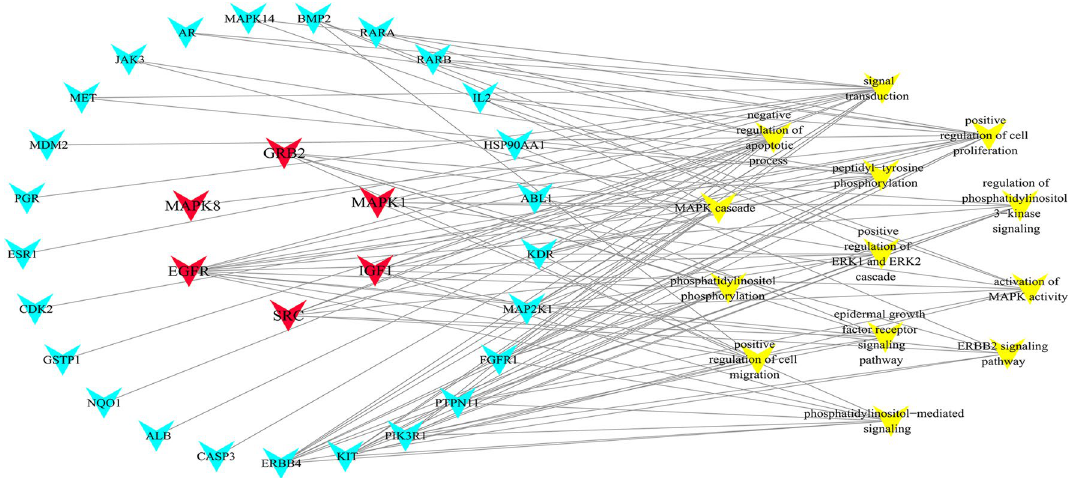
Figure 6. The network made in Cytoscape3.7.2 (https ://cytos cape.org/) depicted the relationship of candidate targets and important biological processes of fucosterol treated NSCLC. (Node in red is the hub gene, node in blue is the candidate targets, and yellow is the specific biological